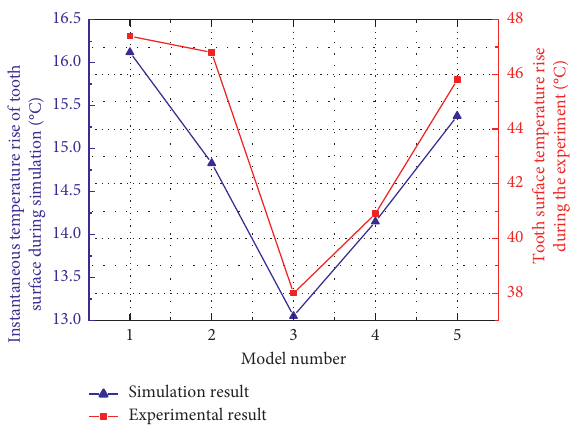
Figure 22: Comparison of the temperature rise of the driving gear tooth surface under different